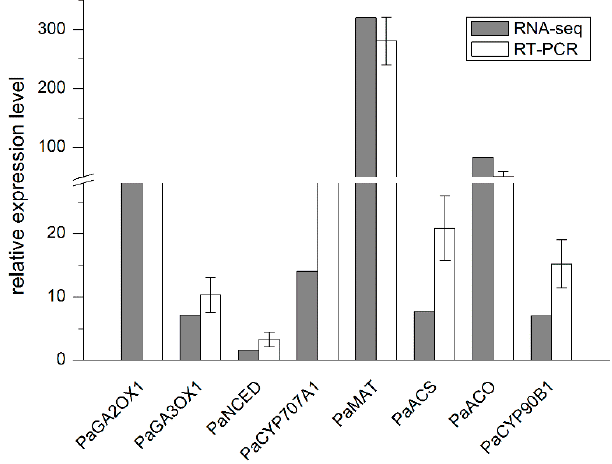
Figure 5. Validation of hormone-related genes at the GR24 treatment stage by qRT-PCR. Fold changes were originally estimated in the RNA-seq experiment (brown bar) and validated by qRT-PCR (white bar). The results are the average of three biological replicates. Abbreviations of genes: PaGA2OX1, gibberellin 2-beta-dioxygenase 1; PaGA3OX1, gibberellin 3-beta-dioxygenase 1;